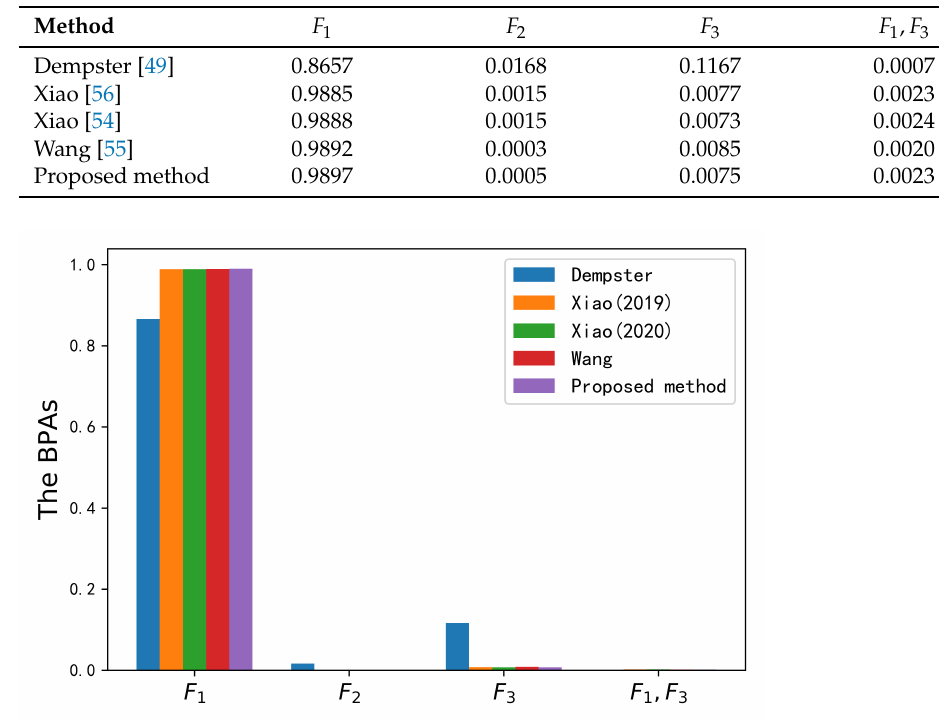
Table 8. Fusion results by different methods in Application 2.